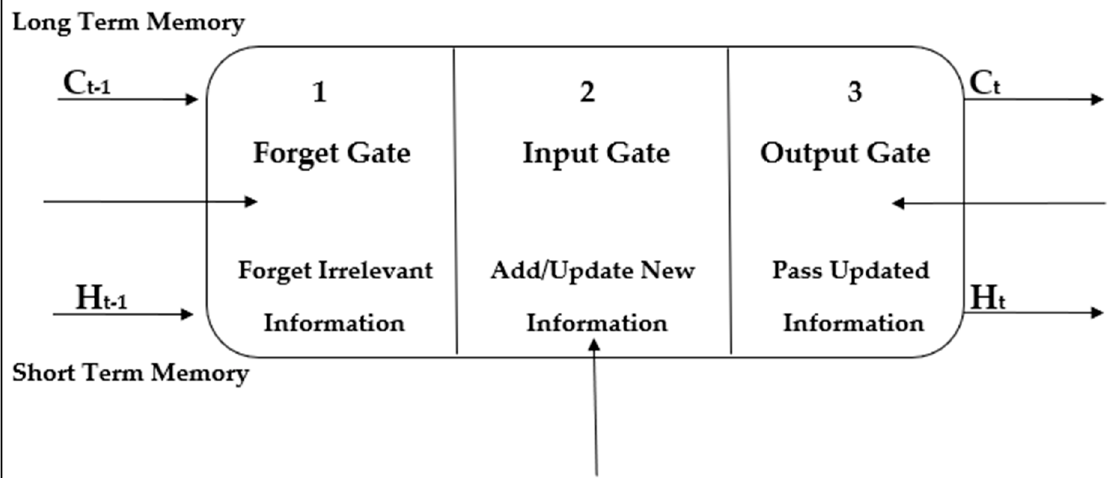
Figure 1. The basic structure of the LSTM [9].